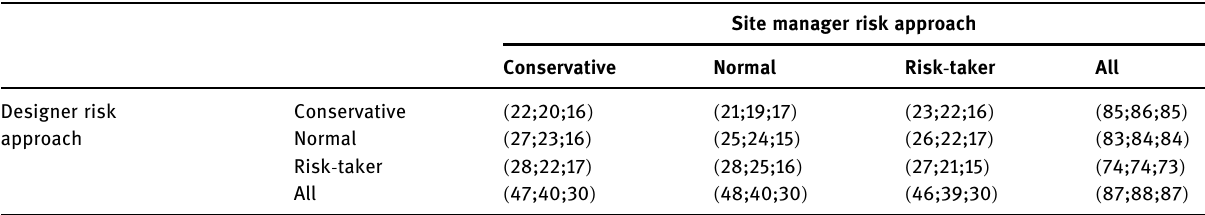
Table 5: Average standard deviation of project completion costs ( in thousands of euros ) for various worker experience ratings ( little; average; high )